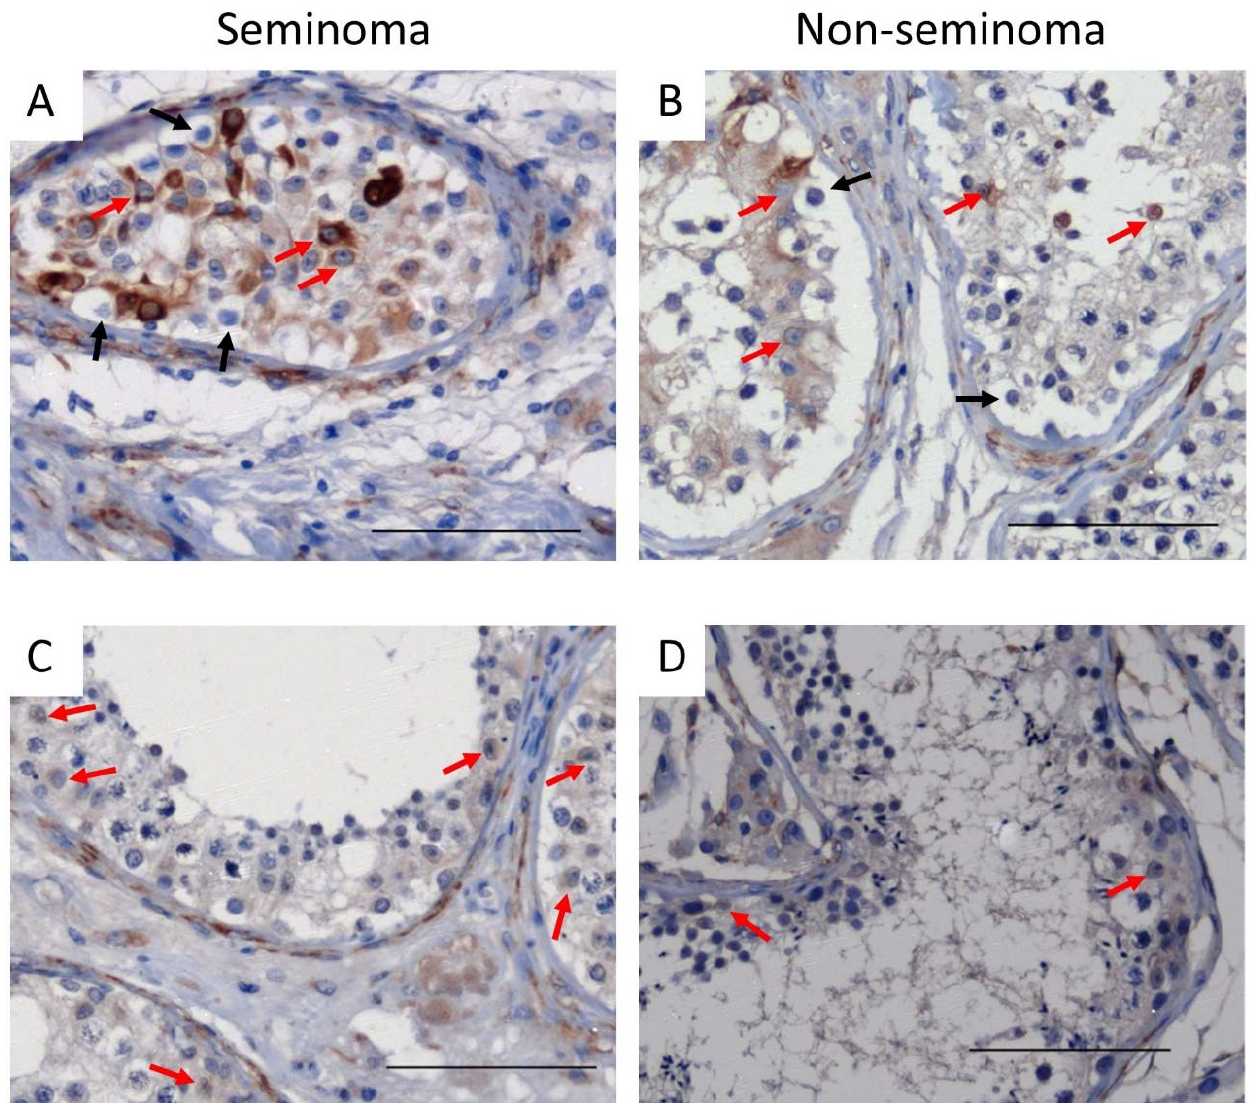
Figure 4. Desmin expression in Sertoli cells of ( A , B ) GCNIS ‐ containing tubules and ( C , D ) tubules with active spermatogenesis on tissue from ( A , C ) seminoma and ( B , D ) non ‐ seminoma patients. Scalebars represent 100 μ M, red arrows: Sertoli cells, black arrows: GCNIS cells. In patients with seminoma or non ‐ seminoma, cytokeratin was heterogeneously expressed in Sertoli cells in tubules containing GCNIS cells (Figure 5A,B) whereas, in tubules with active spermatogenesis, cytokeratin was not observed (Figure 5C,D).